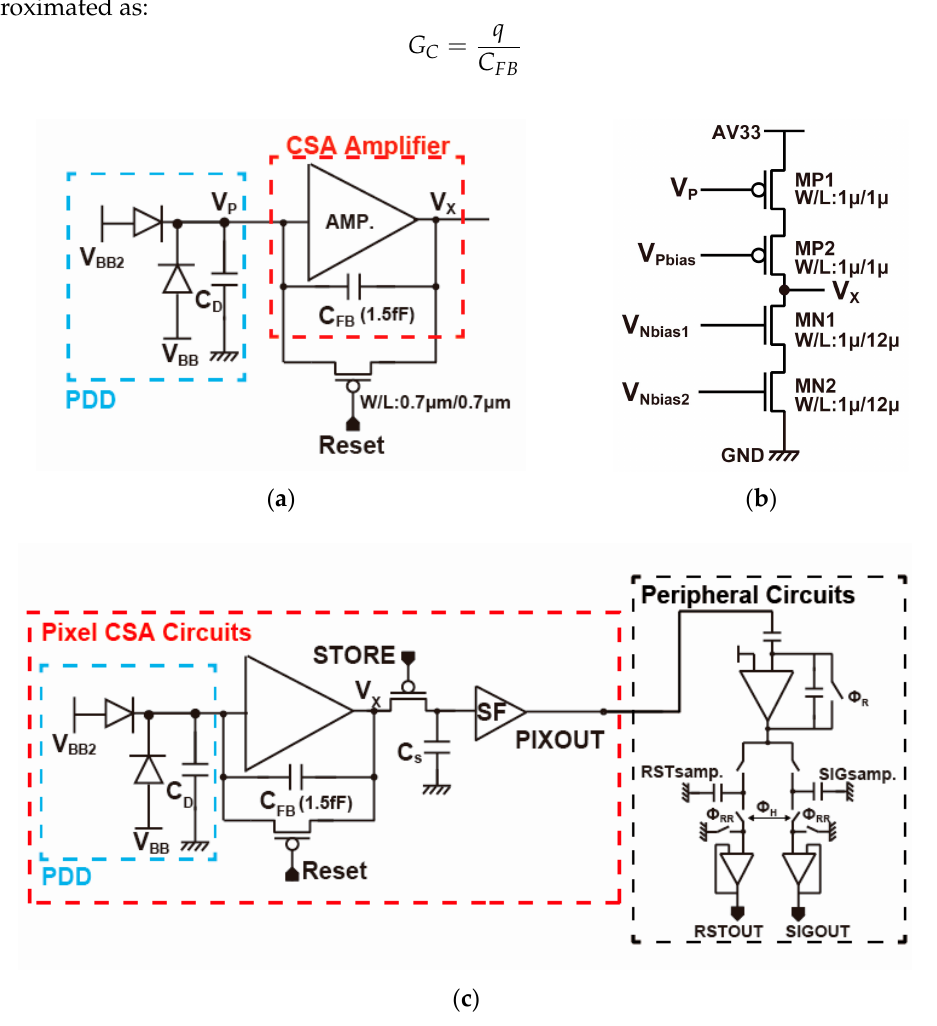
Figure 9. Equivalent circuits of the CSA in the pixel. ( a ) Model of CSA including those for the substrate detector, ( b ) internal amplifier, ( c ) Equivalent readout circuits chain including the pixel and peripheral.